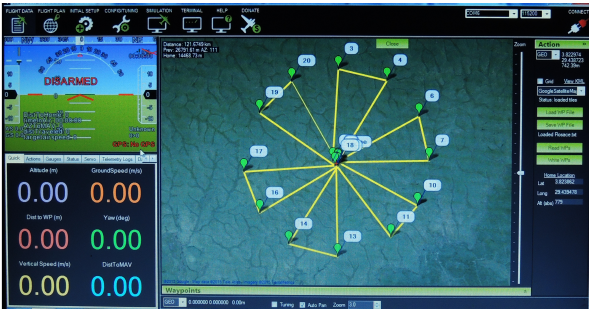
Figure 3. Rosette flight plan designed on Mission Planner© The trial was repeated twice over the same area at an average flight altitude of 100 m as it was previously assessed a good compromise between detection and covered band. The overlap between photos was respectively 60 % and 80%.